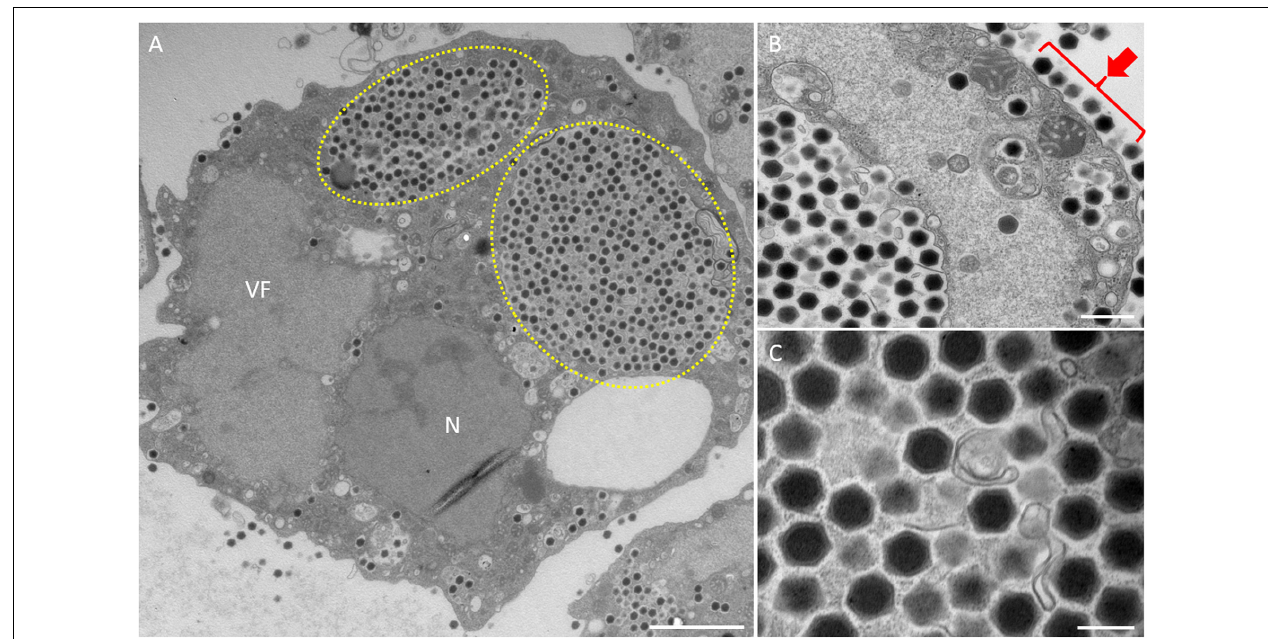
FIGURE 2 | TEM images of ultrathin sections of amoeba cells infected with the new viruses isolated from a small reservoir near Hokuto Town in Kashiwazaki City (named hokutovirus). (A) TEM image of a typical virion factory (VF) in the cytoplasmic region of the amoeba cells. N indicates an amoeba cell nucleus. Yellow circles indicate membrane bags. Scale bar: 2 µ m. (B) Enlarged image of virus particles in the amoeba cytoplasm. Red arrow indicates viral particles surrounding cell membrane. Scale bar: 500 nm. (C) Enlarged image of viral particles in the amoeba cytoplasm. Scale bar: 200 nm.